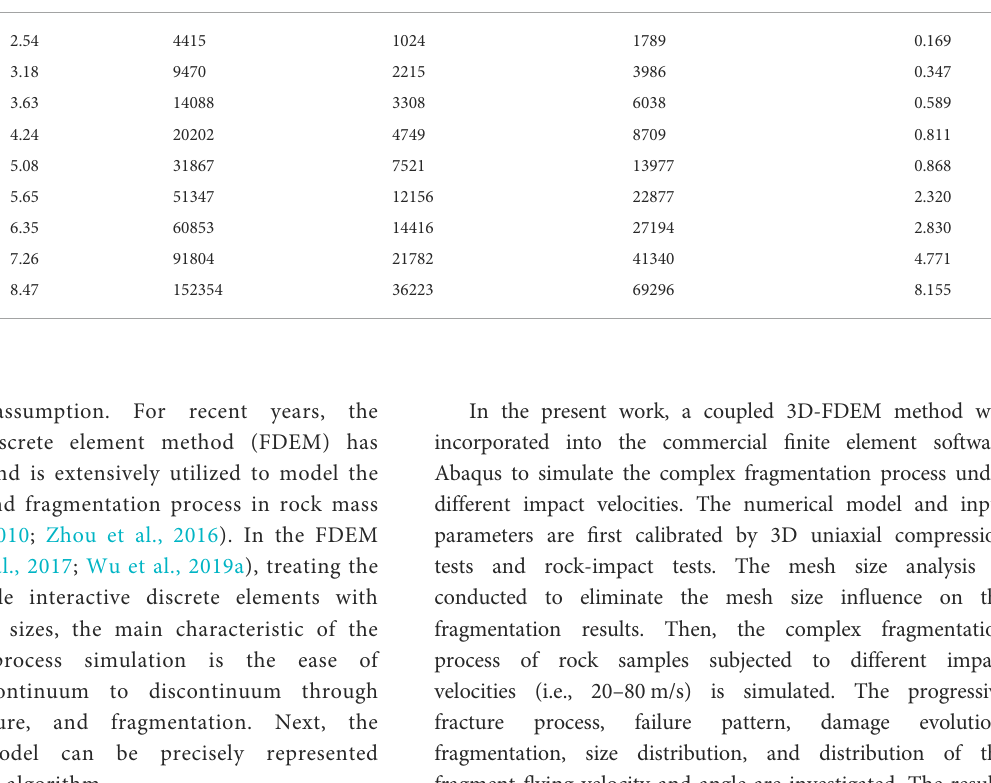
TABLE 4 Mesh size analysis of a cylinder model impact onto the rigid wall. Mesh size (mm)